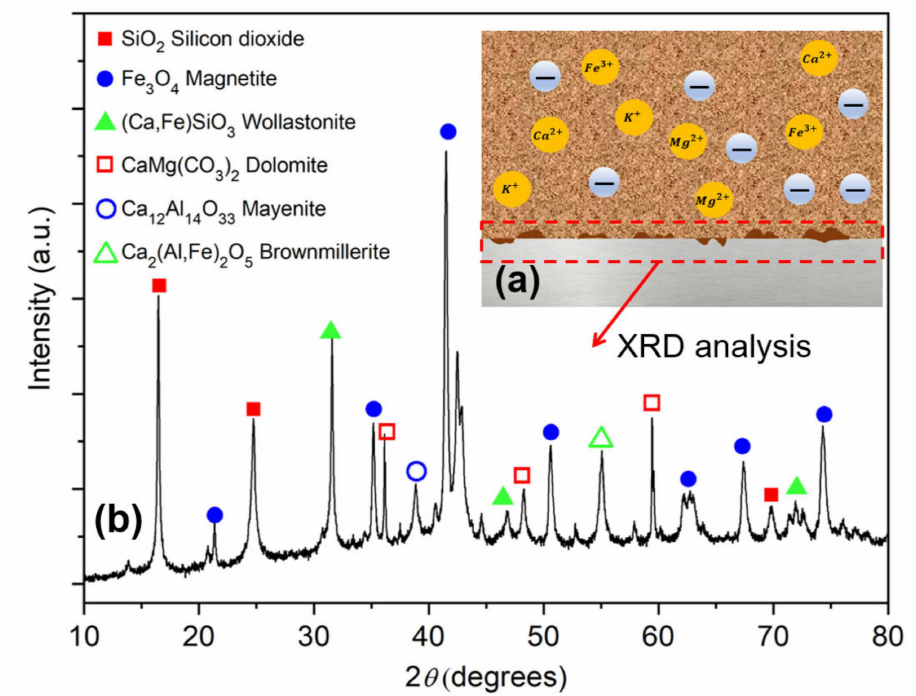
Figure 3. ( a ) Schematic of metal ions (Fe 3+ , Ca 2+ , K +, and Mg 2+ ) that leach out from the insulation and ( b ) X-ray diffraction characterisation of corrosion products formed upon the steel pipe during its interaction with moist insulation, analysed by Cao et al.